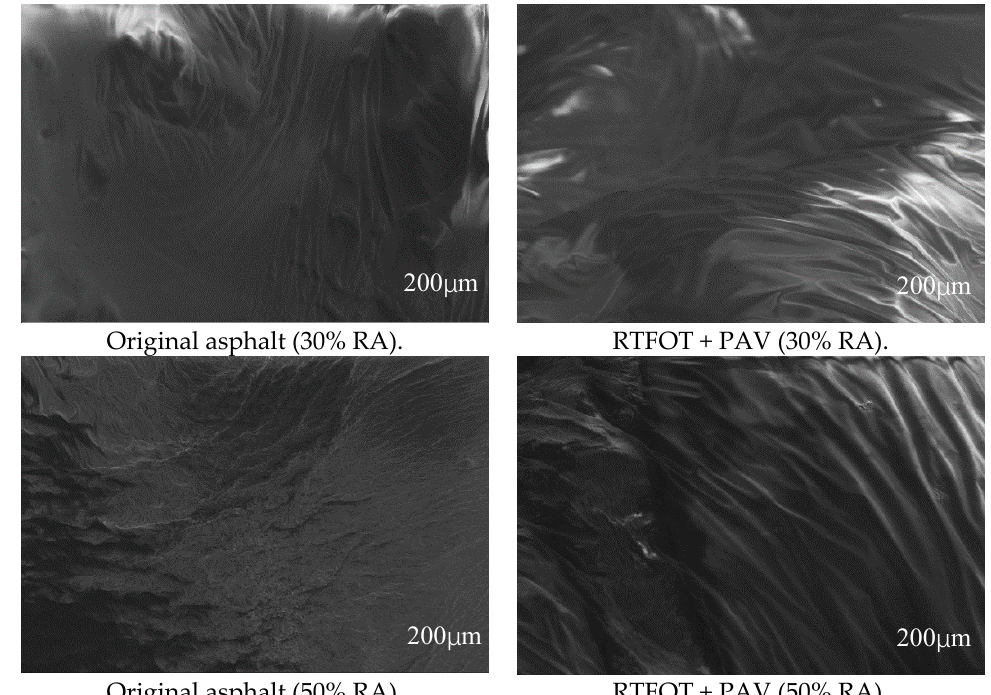
Figure 13. Microstructure of high-content rubberized asphalt.